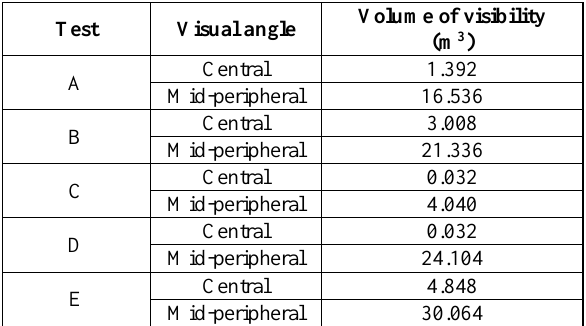
Table 2. Results of visibility tests in terms of volume of the space